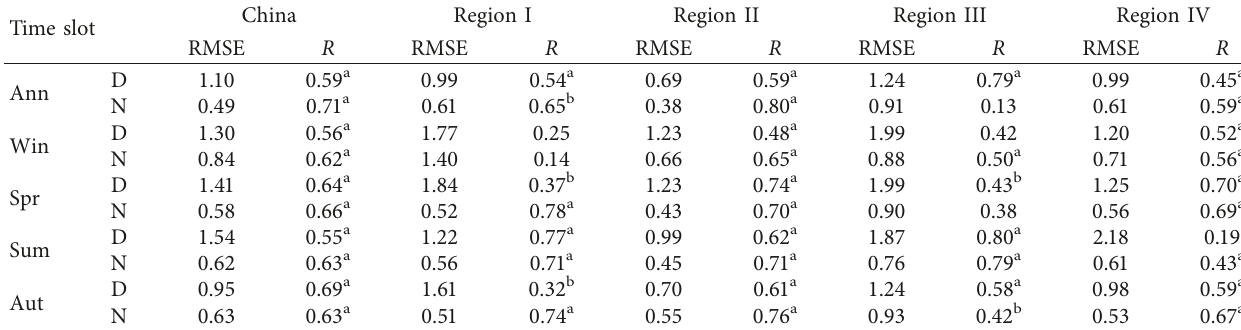
Table 3: Accuracy statistics for the daytime and nighttime SUHII simulation for all of China and its four regions annually and for four seasons. Time slot